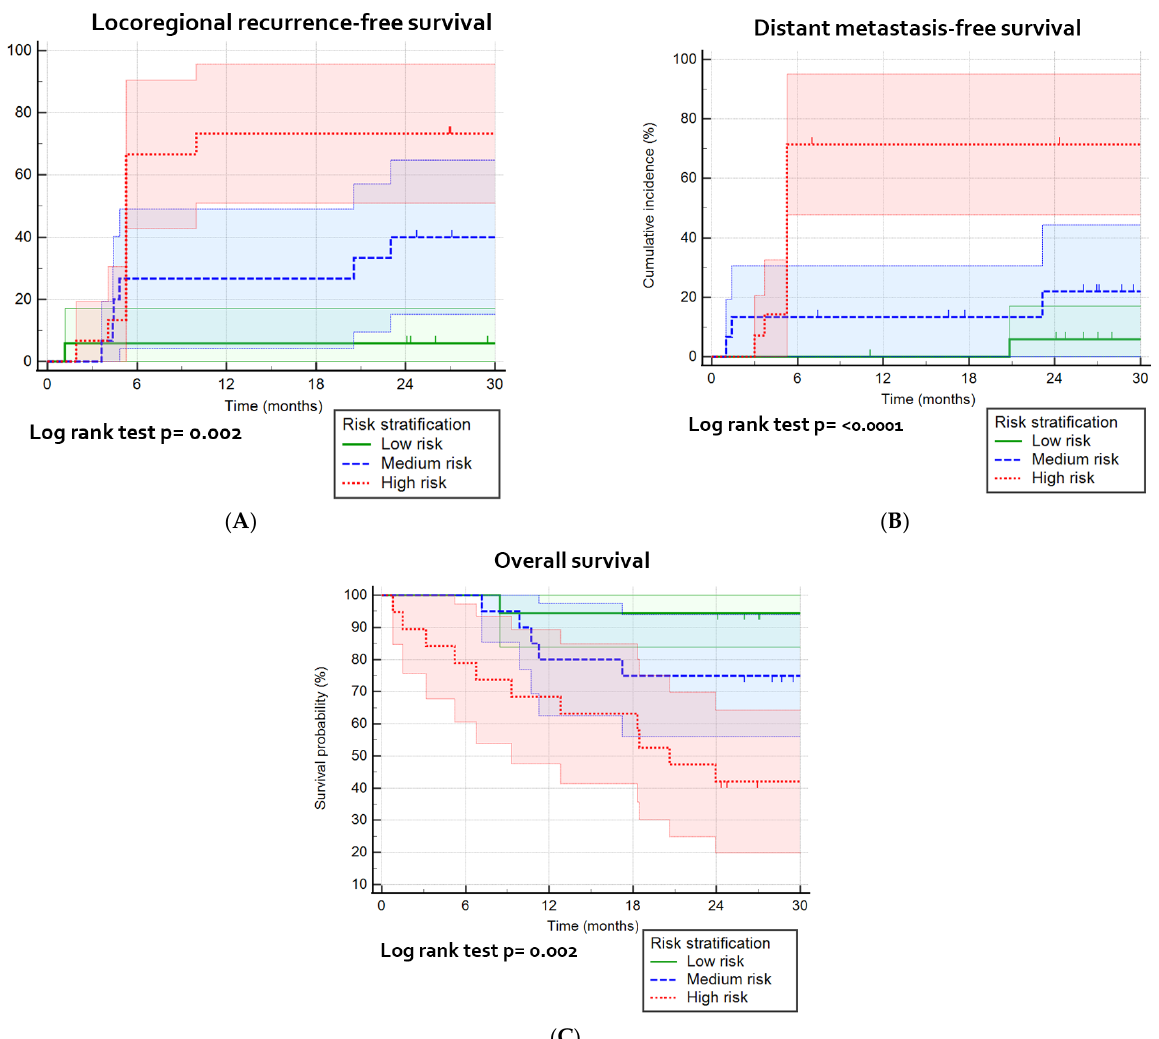
Figure 5. Kaplan–Meier survival curves and the log-rank test for the most optimal prognostic models: ( A ) the combination of pretreatment, intratreatment and delta parameters for the cumulative incidence of locoregional recurrence, divided into high/medium/low risk groups; ( B ) prediction model with pretreatment parameters for the cumulative incidence for distant metastasis, divided into high/medium/low risk groups; and ( C ) prediction model with pretreatment parameters prognostic for overall survival, divided into high/medium/low risk groups.